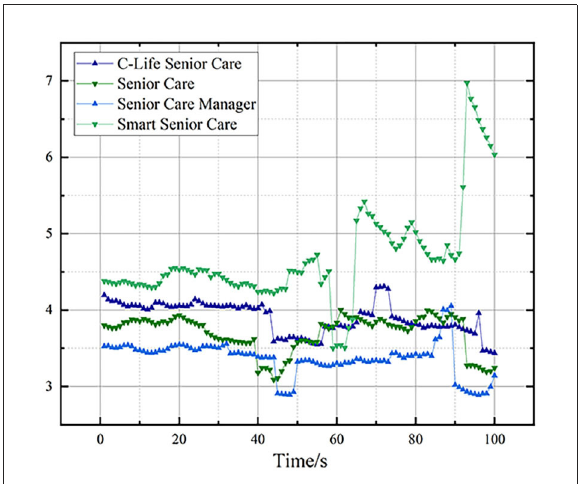
FIGURE3 The average value of the skin signal movement of the four